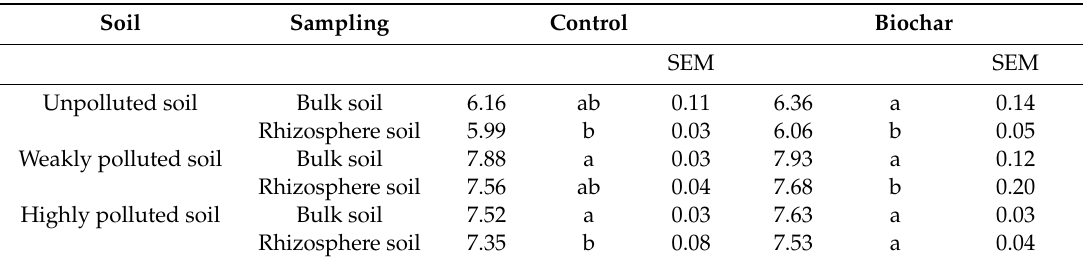
Table 5. Soil pH (d-water) measured in rhizosphere soil and bulk soil after 4 weeks growth of barley on three di ff erently polluted